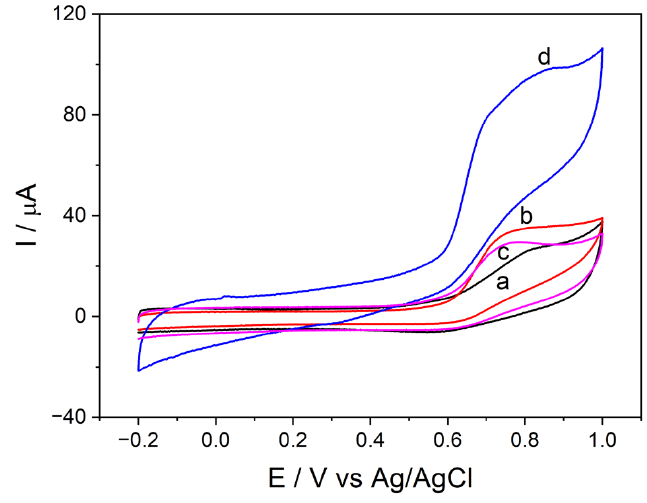
Figure 3. Cyclic voltammograms recorded for: MWCNT/SPE (a), MWCNT-CS/SPE (b), MWCNT- 1,8-DAN/SPE (c), and MWCNT-SG/SPE (d) (PBS 0.1 M, pH 7, v = 0.05 V/s).